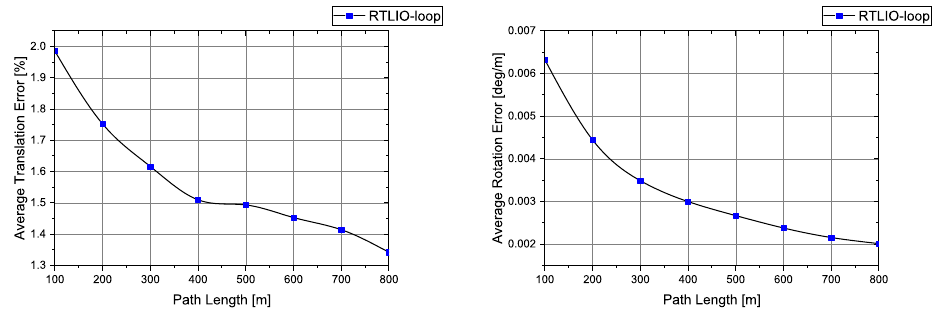
Figure 14. Average translation and rotation errors of the full pipeline evaluated over different lengths in the KITTI dataset for sequences 00 to